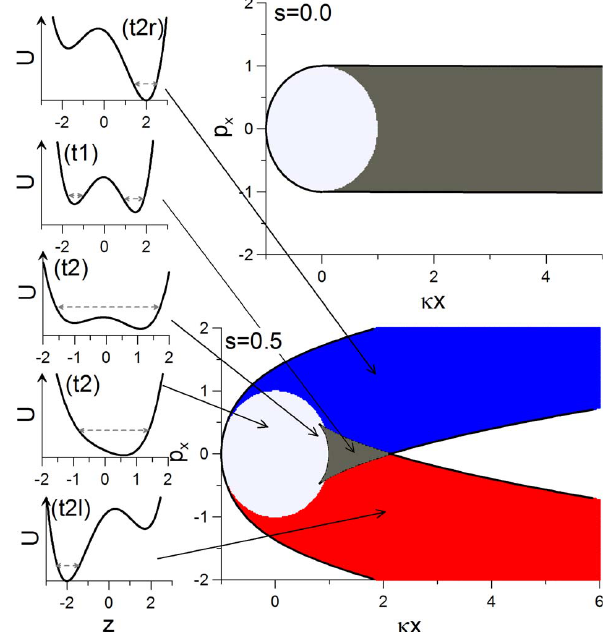
Fig. 3. The phase plane of slow variables (κx,p x ) is shown for two values of the parameter s . Various colours are used for domains with different types of particle motion. Dotted grey lines show the position of energy level U = 1 /